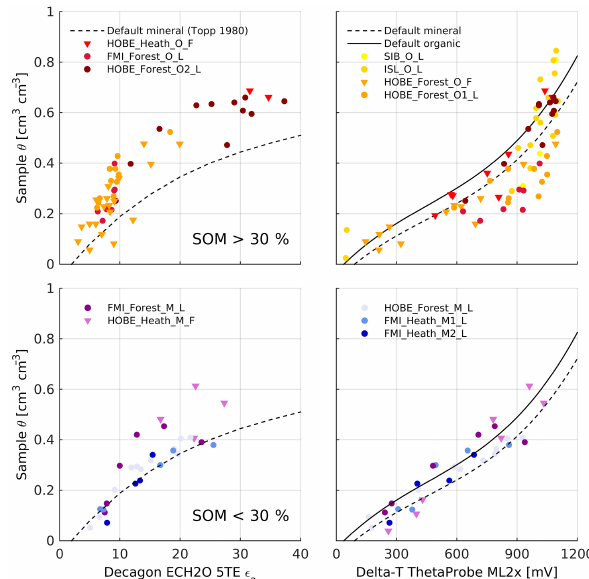
Figure 2. Decagon 5TE apparent relative permittivity ε a (left pan- els) and ThetaProbe voltage (mV) (right column panels) against volumetric moisture content θ for organic (SOM > 30%, top row panels) and mineral soil horizons (SOM < 30%, bottom row pan- els), laboratory • and field (cid:72) data, with color codes from highest to lowest SOM content (yellow–dark red and purple–dark blue, re- spectively). For mineral horizons, blue and purple signatures mean SOM < 10 and > 10%, respectively. Manufacturer’s default cal- ibration curves (black dashed and continuous lines) are also in- cluded. Regarding the specifications of sample names and respec- tive SOM fractions, please see Table